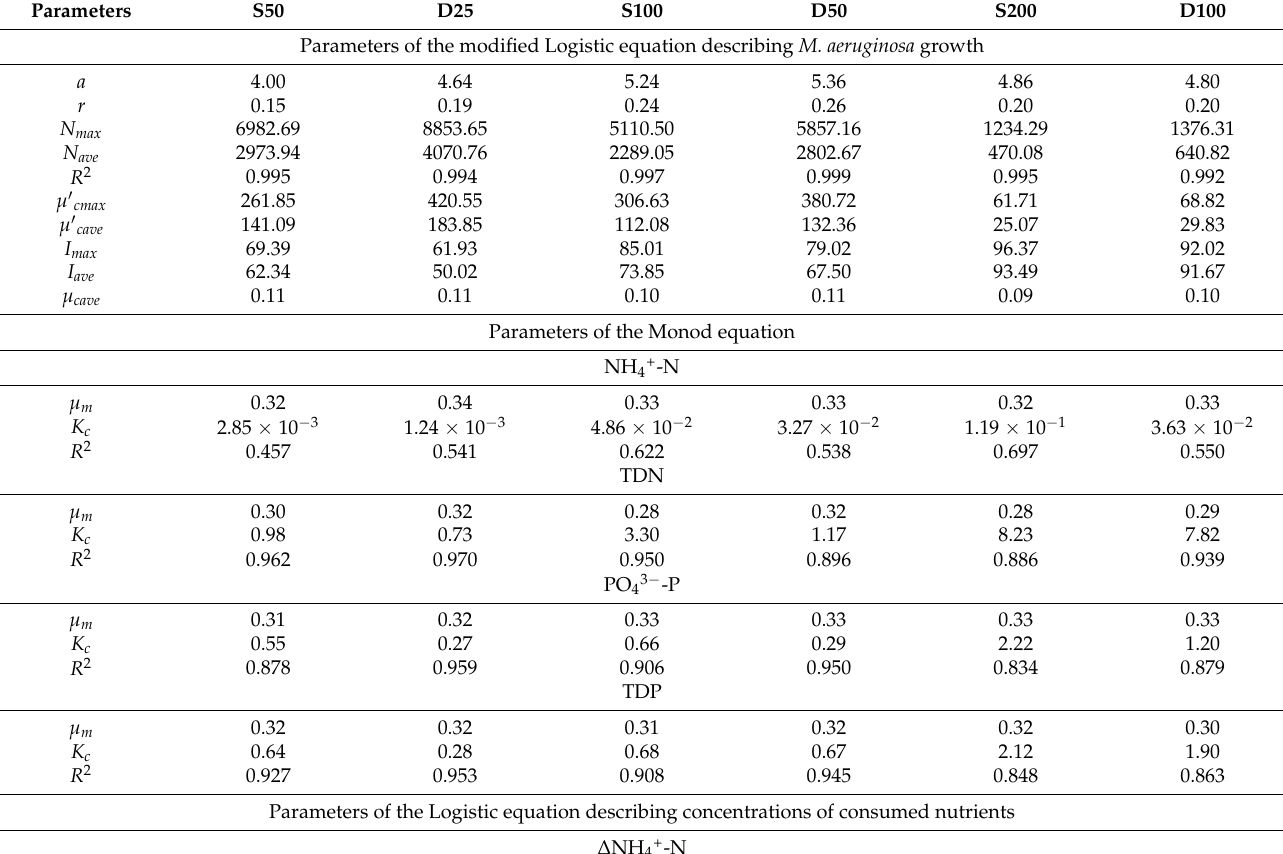
Table 1. Parameters of M. aeruginosa growth, concentrations of nutrients, and concentrations of consumed nutrients. Parameters Parameters of the modified Logistic equation describing M. aeruginosa